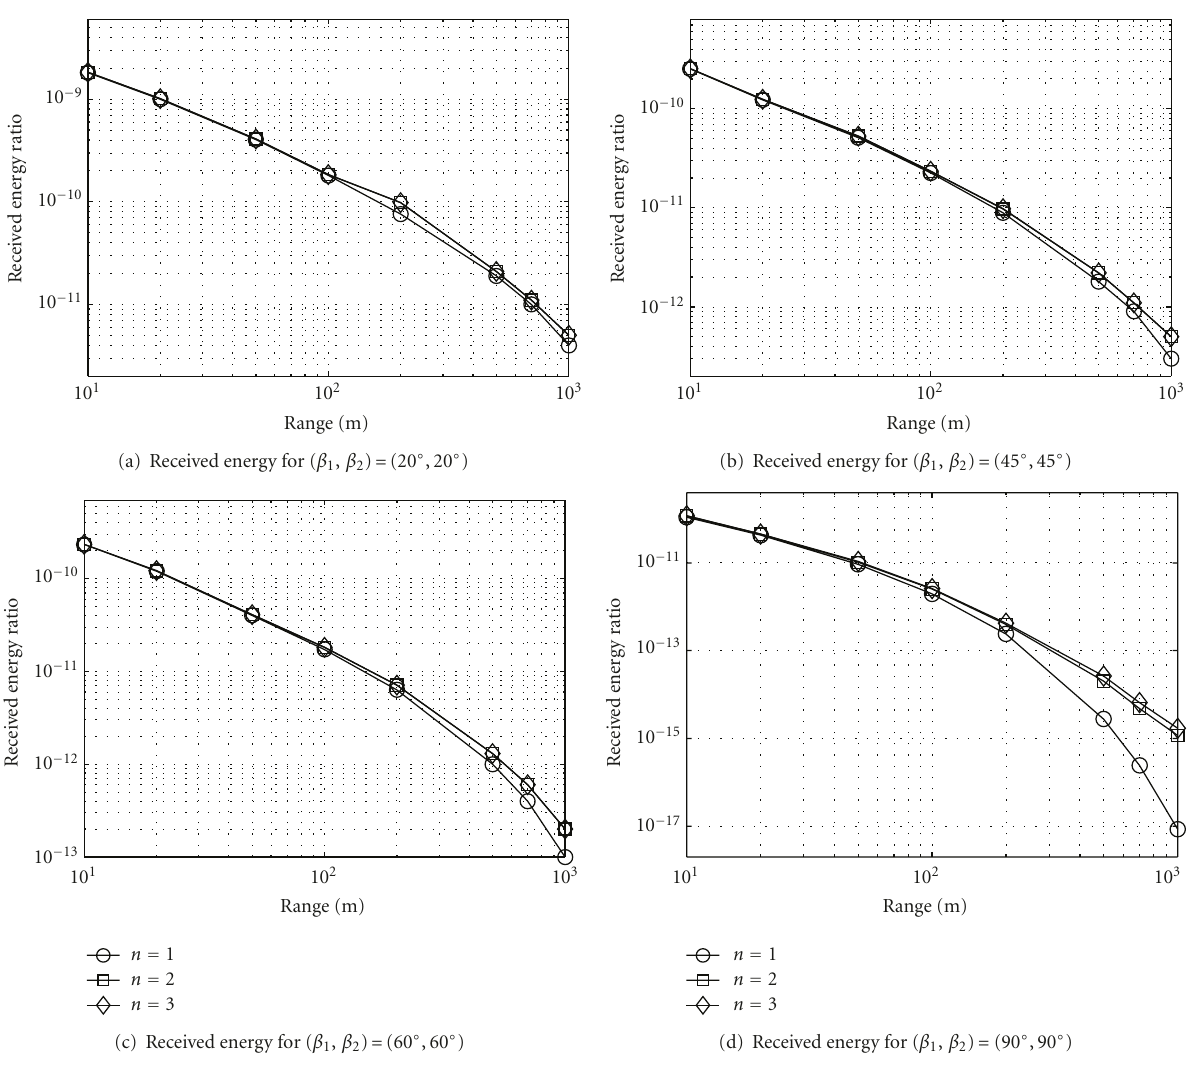
Figure 3: Received energy ratio predicted by the proposed